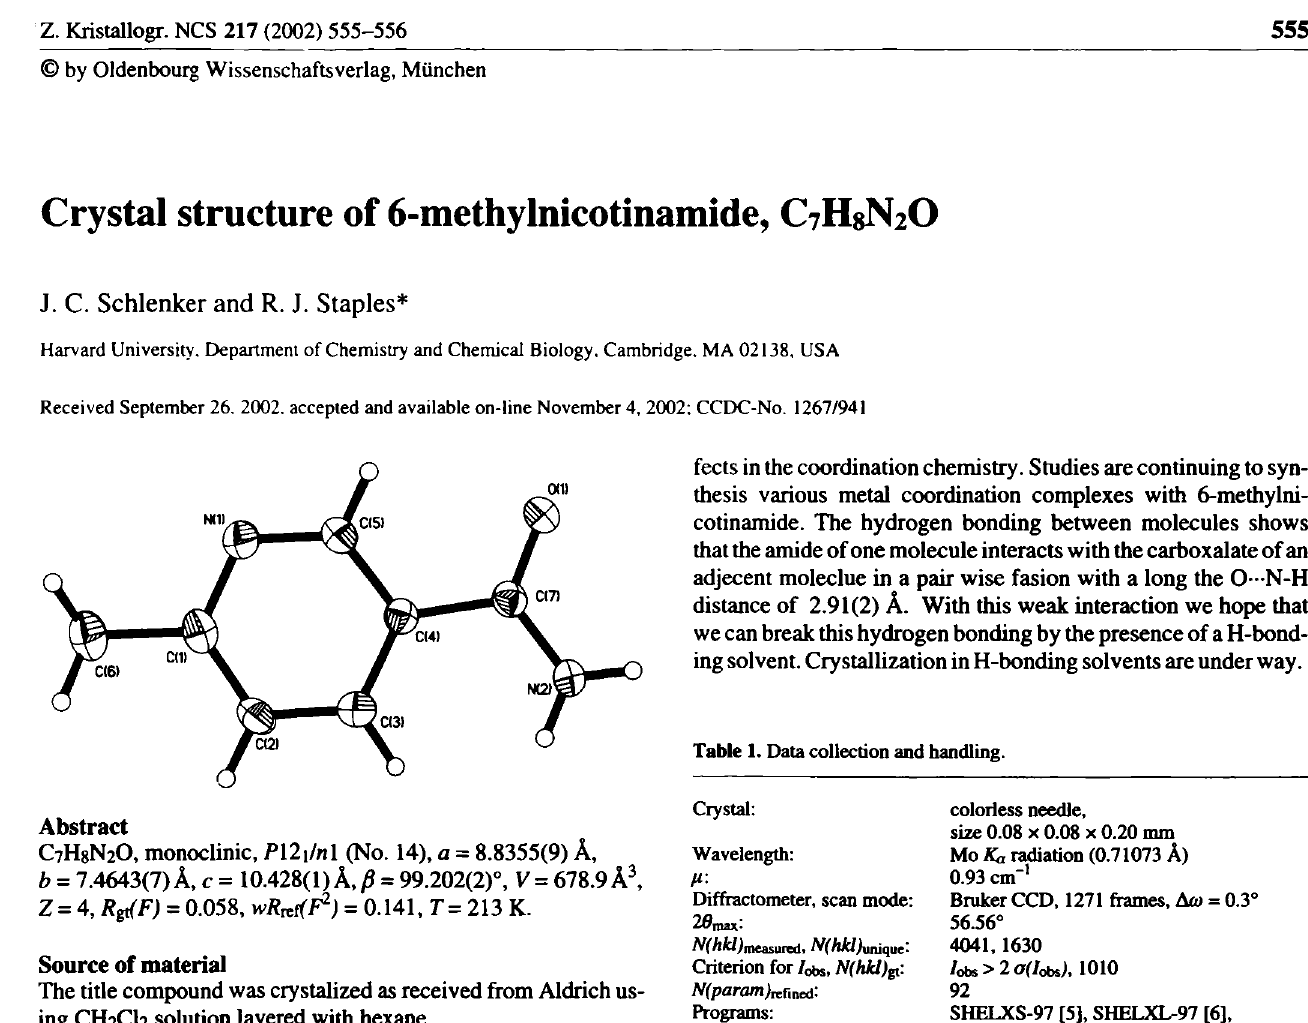
Table 2. Atomic coordinates and displacement parameters (in Â 2 ).